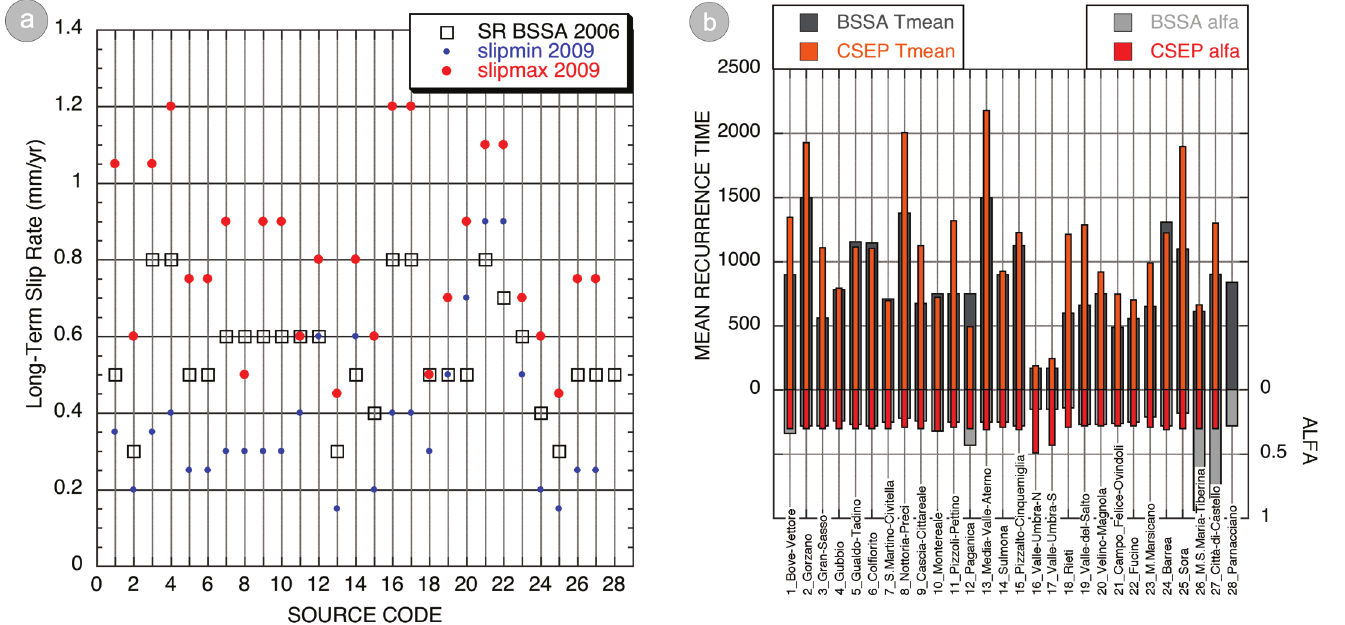
Figure 5. Implementations made to the CSEP test based on the SB sources. (a) Slip-rate uncertainties associated with each fault. Black square, slip rate used in Pace et al. [2006] and revised according to the literature. (b) Mean recurrence times (left y-axis) and aperiodicities ( ALFA , right y-axis) assigned to the faults in 2006 (gray bars) and in 2009 (colored bars) according to the error propagation technique described by Peruzza et al.